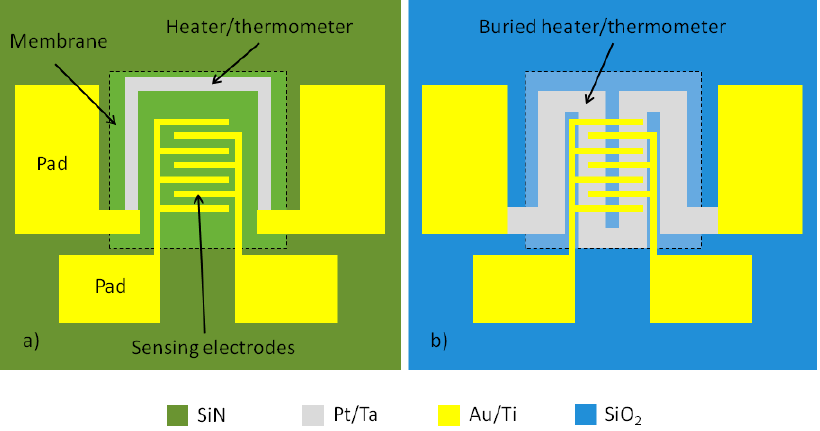
Figure 1. Layout of the micro-hotplate designed according to the coplanar ( a ) and buried ( b ) approaches.